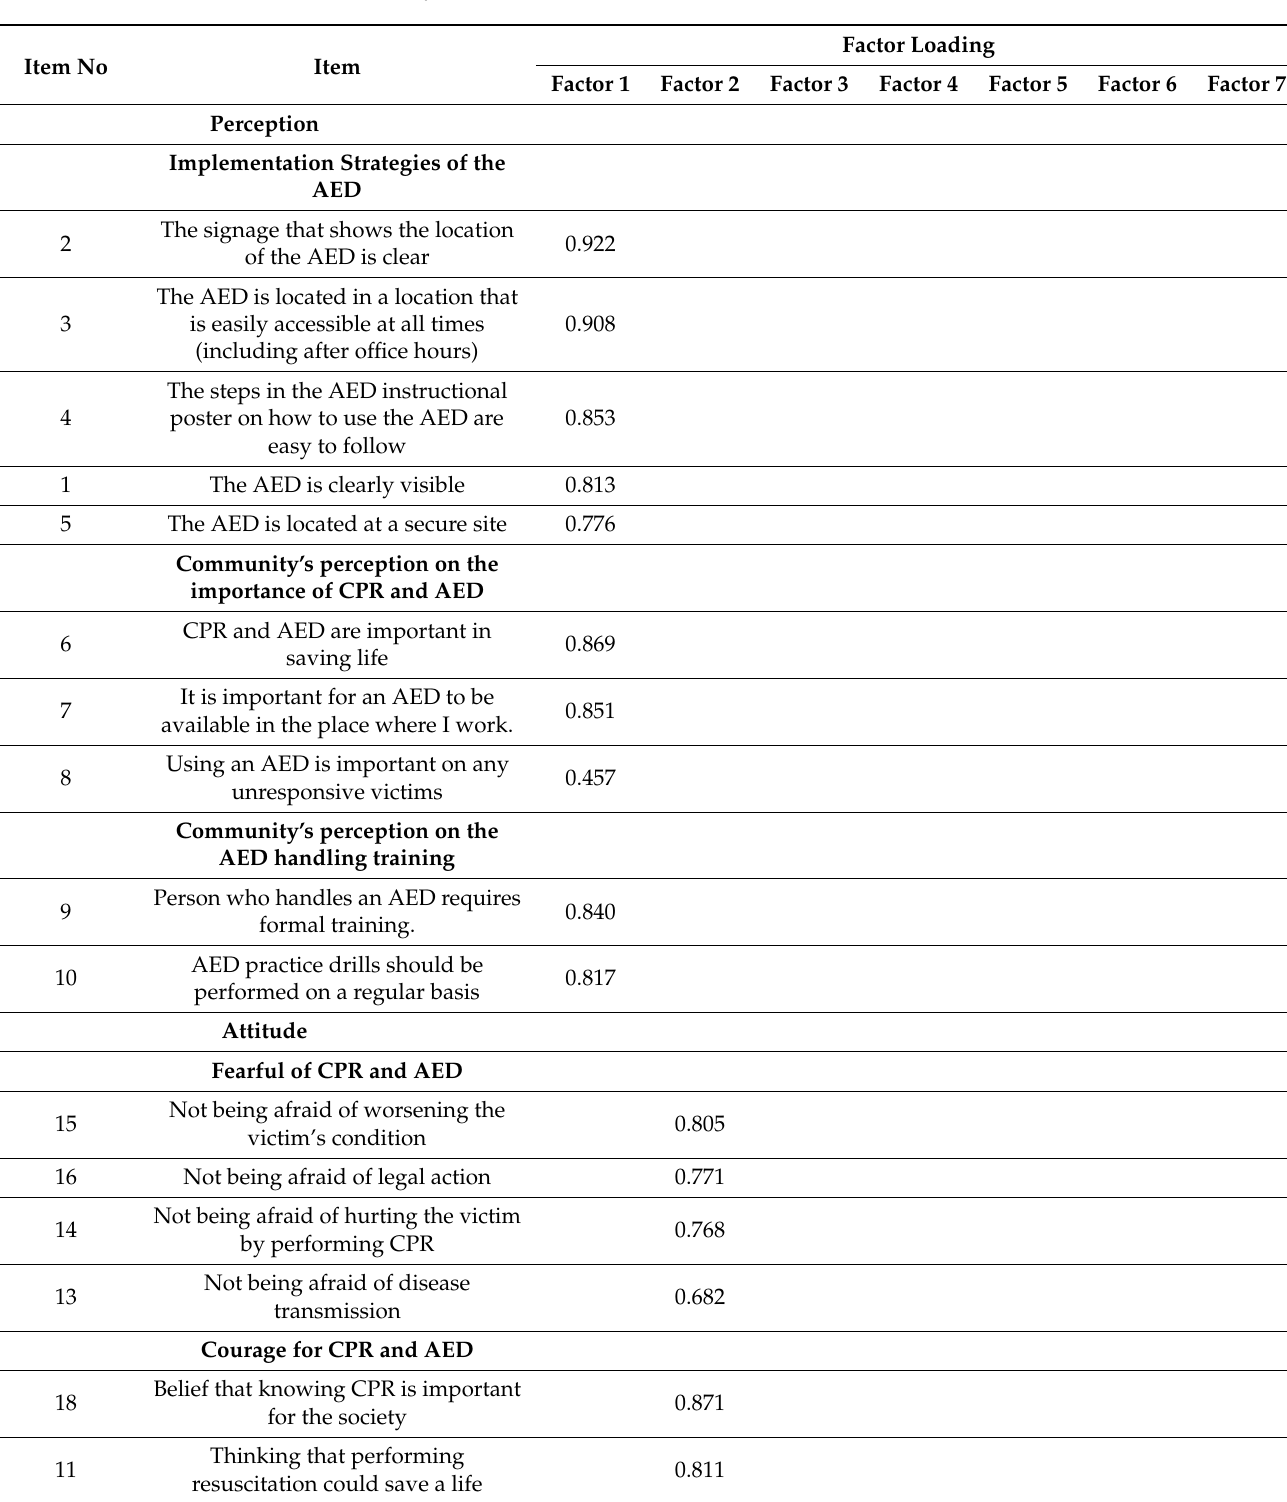
Table 4. Factor analysis by PCA after varimax rotation for the perception, attitude, perceived norms, self-efficacy, intention, behaviour, and barriers